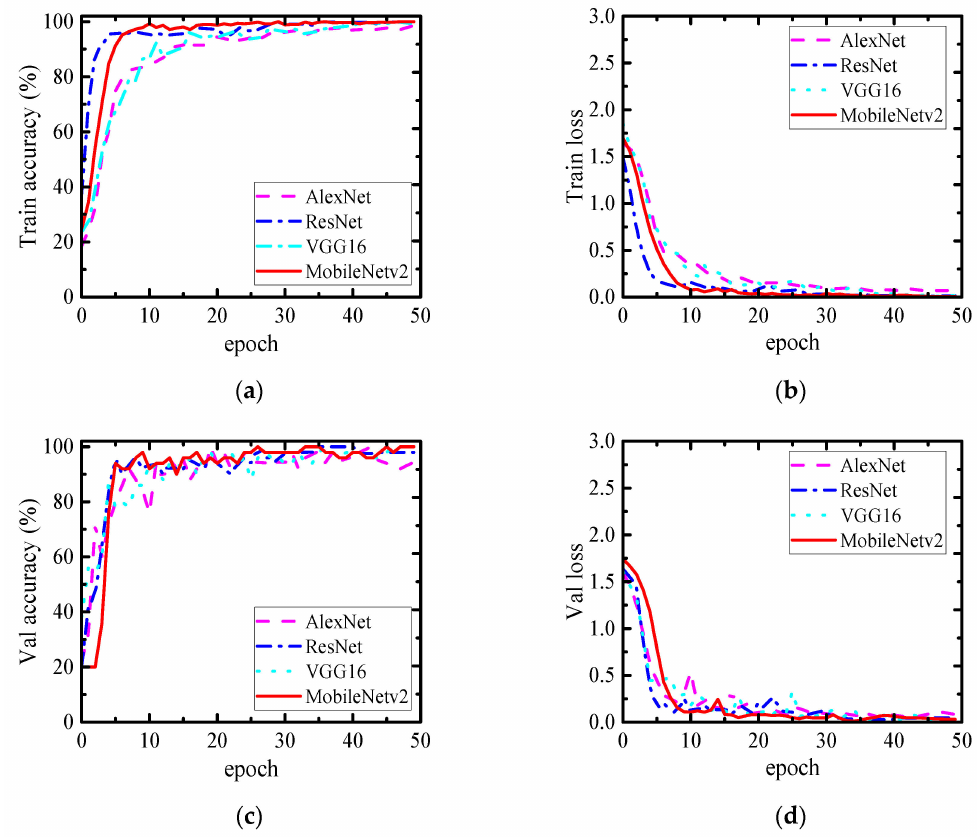
Figure 13. Results of vehicle speed identification of different models: ( a ) Training accuracy curves of response samples; ( b ) Training loss curves of the response samples; ( c ) Validation accuracy curves of the response samples; ( d ) Validation loss curves of response